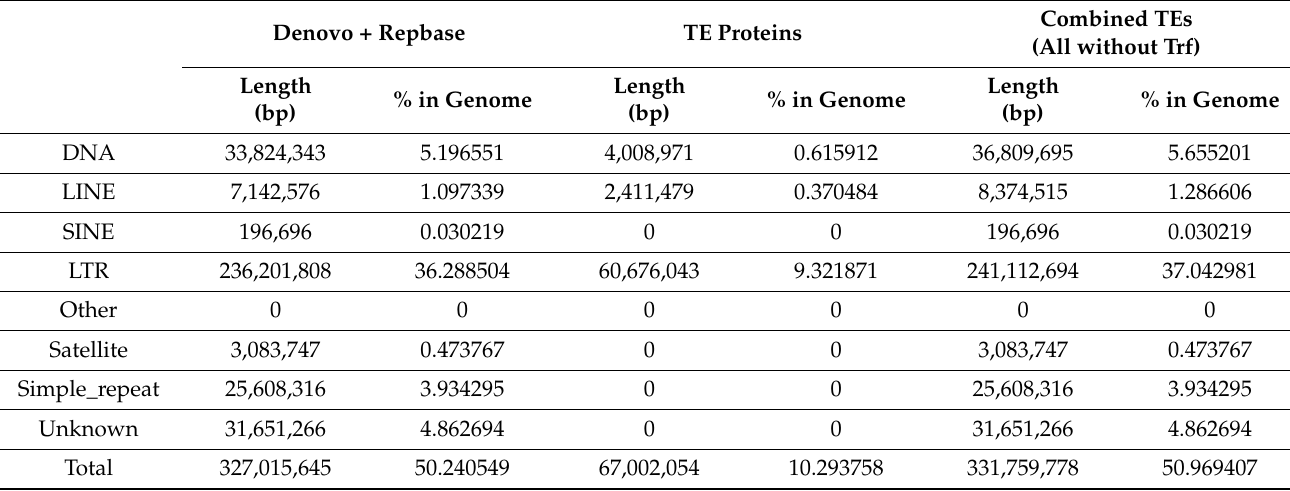
Table 5. Statistics of transposable element (TE) classification in C. roscoffensis genome.